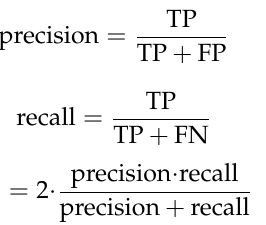
Table 1. Accuracy assessment of cottage’s plane segmentation using the proposed method under